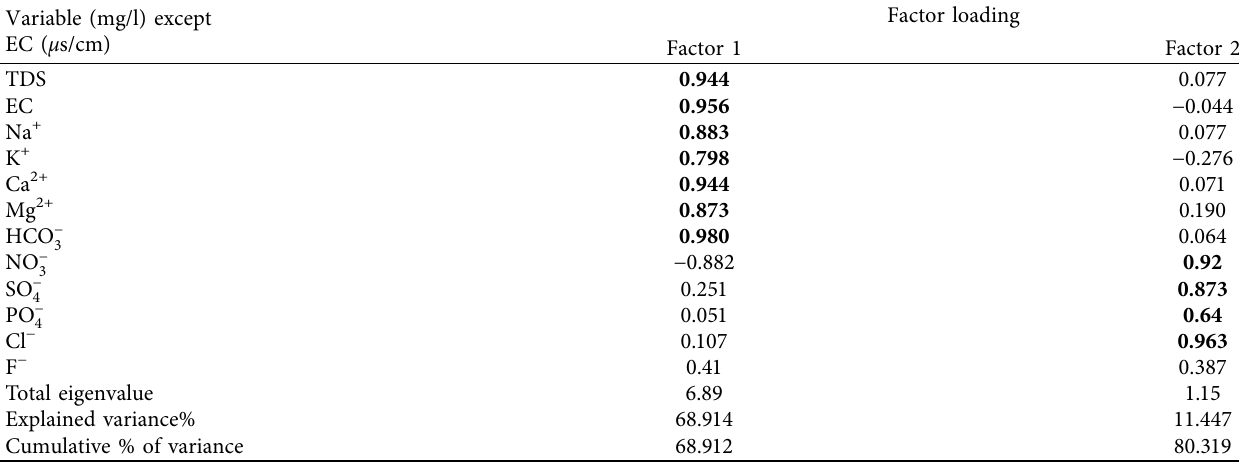
Table 4: Factor loadings and eigenvalues matrix of each hydrogeochemical parameters.